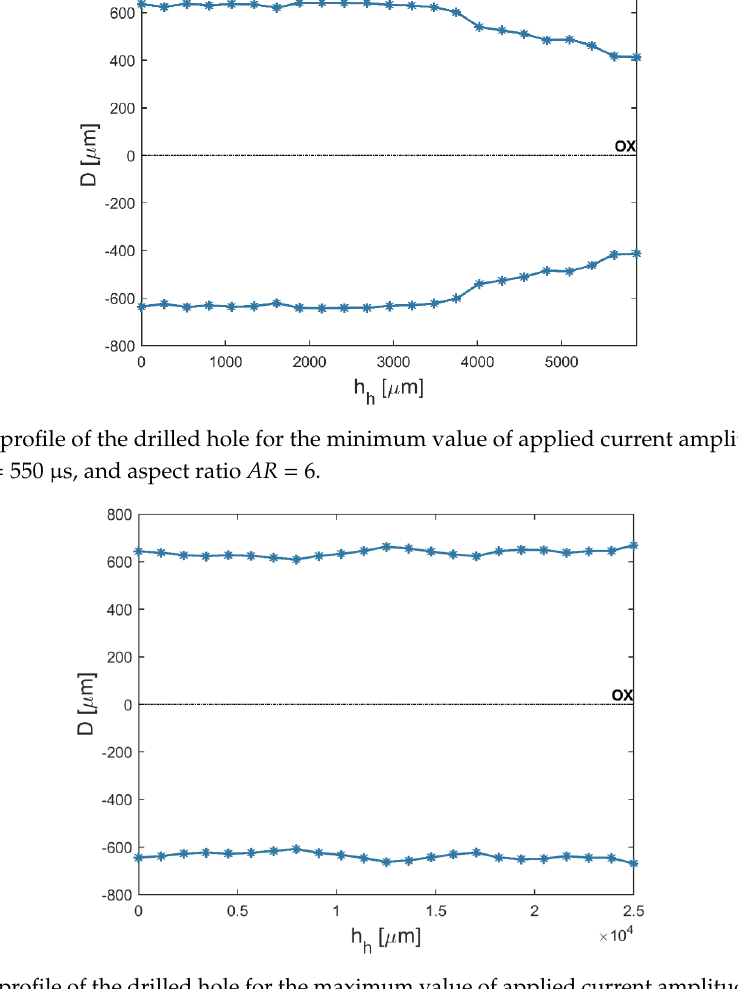
Figure 6. The profile of the drilled hole for the maximum value of applied current amplitude I = 4.65 A, U = 100 V, t i = 550 μs, and AR = 19.